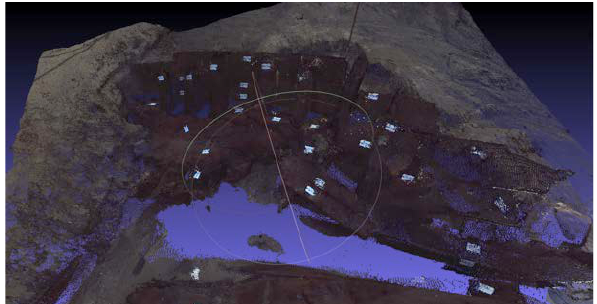
Figure 12. Point cloud